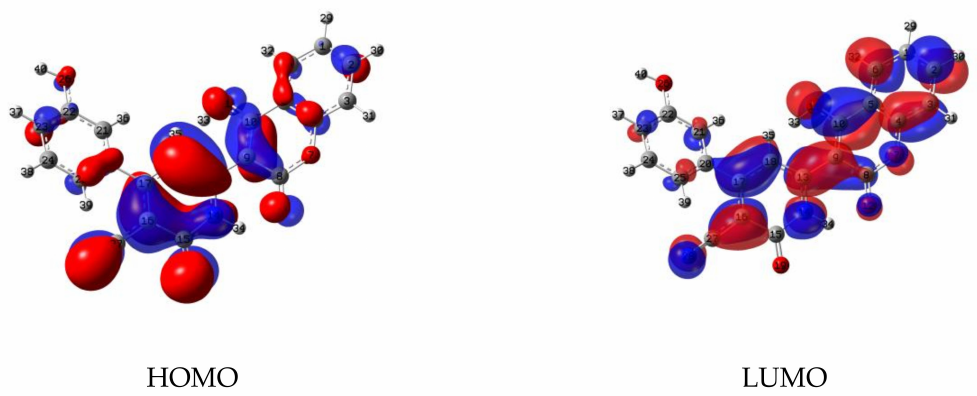
Figure 3. Molecular Orbitals MOs (HOMO and LUMO) of the desired product.